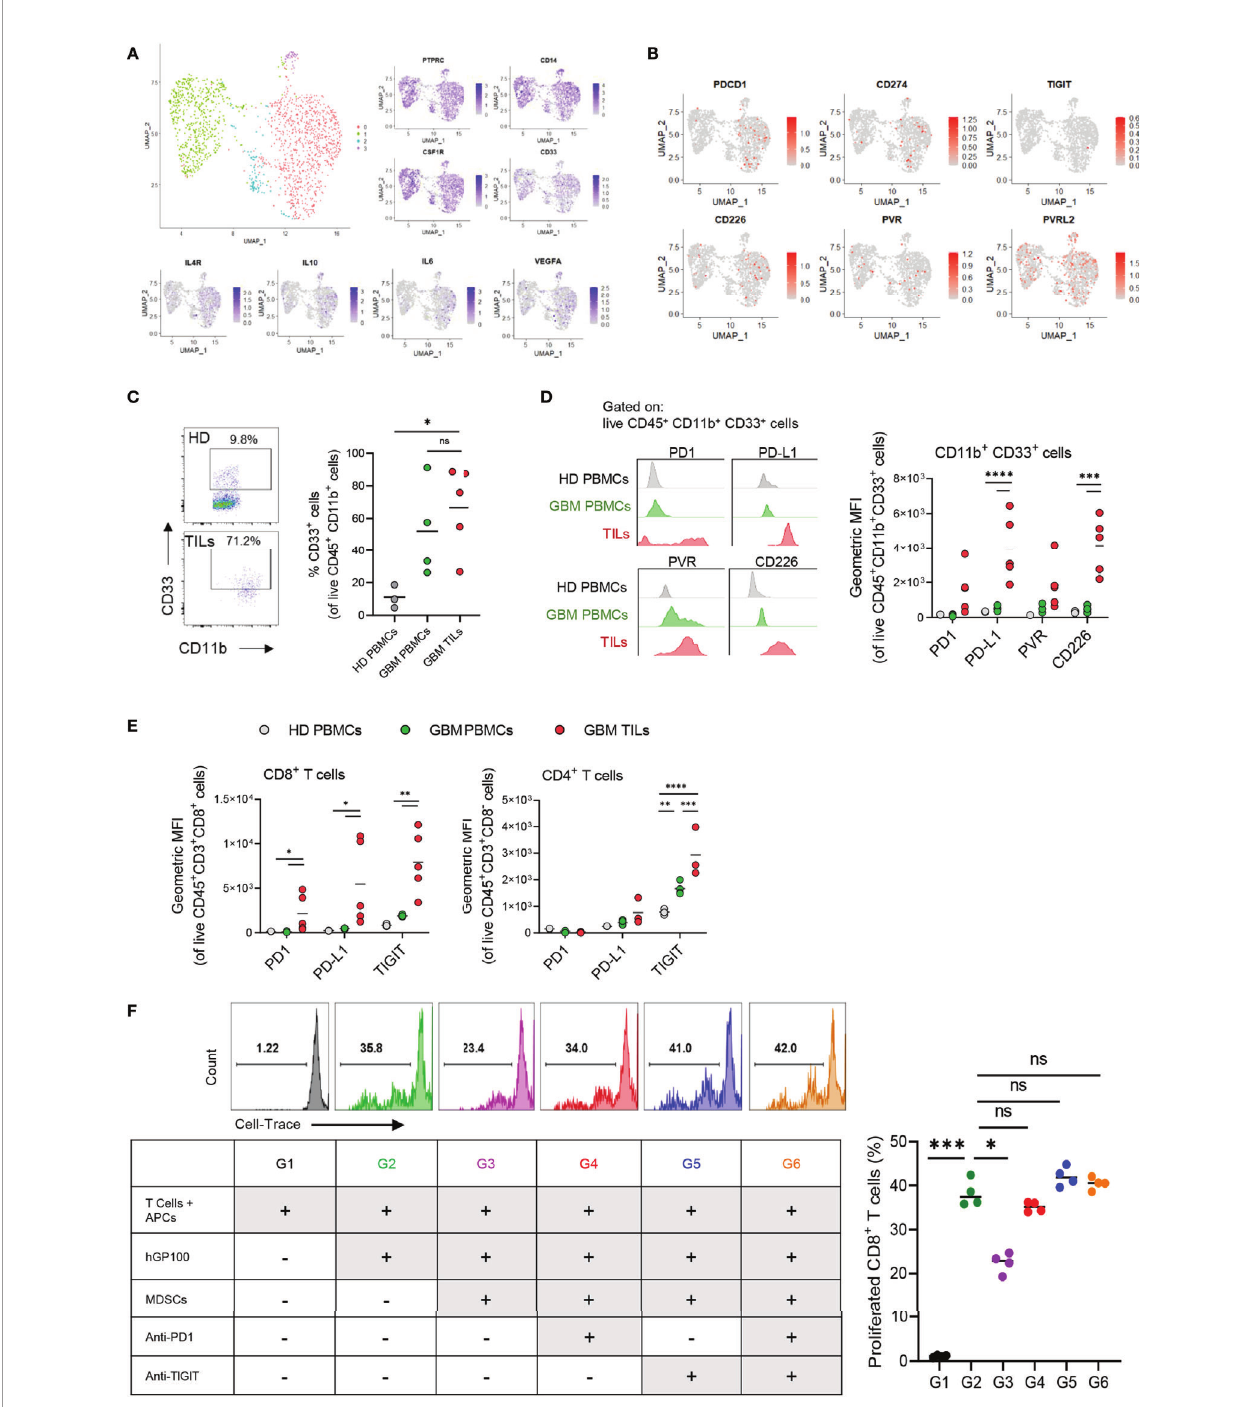
FIGURE 6 | PD1, PD-L1 and TIGIT-ligands are expressed on myeloid suppressor cells in GBM and contribute to T cell dysfunction. Single cell (sc) RNA-seq analysis was performed on myeloid cells from GBM patients. (A) UMAP clustering and expression (z-scores) of suppressive myeloid cell markers. (B) Expression z-scores of PD1/TIGIT-associated checkpoint molecules in the scRNA-seq clusters. (C – E) Healthy donor (HD) PBMCs and GBM patient PBMCs and TILs analyzed fl ow cytometry for myeloid cells, T cells, and IC markers. n = 4 HD; n = 5 GBM patients. (C) Representative fl ow cytometry plots and percentages (%) of CD11b + CD33 + myeloid cells. (D) Representative histograms and mean fl uorescence intensity (MFI) of PD1, PD-L1, PVR, and CD226 on CD11b + CD33 + cells. (E) MFI of PD1, PD- L1, PVR, and CD226 on CD8 + T cells and CD4 + T cells. (F) T cell proliferation assay of murine hGP100-reactive CD8 + T cells cultured with immunosuppressive myeloid cells with a TIGIT and a PD1. Representative histogram plots and percentages (%) of proliferated CD8 + T cells at different culture conditions as indicated in the table lagend. n=4 per group. One-way ANOVA with Tukey multiple comparisons correction. ns, not signi fi cant. p = *<0.05, **<0.01, ***<0.001,